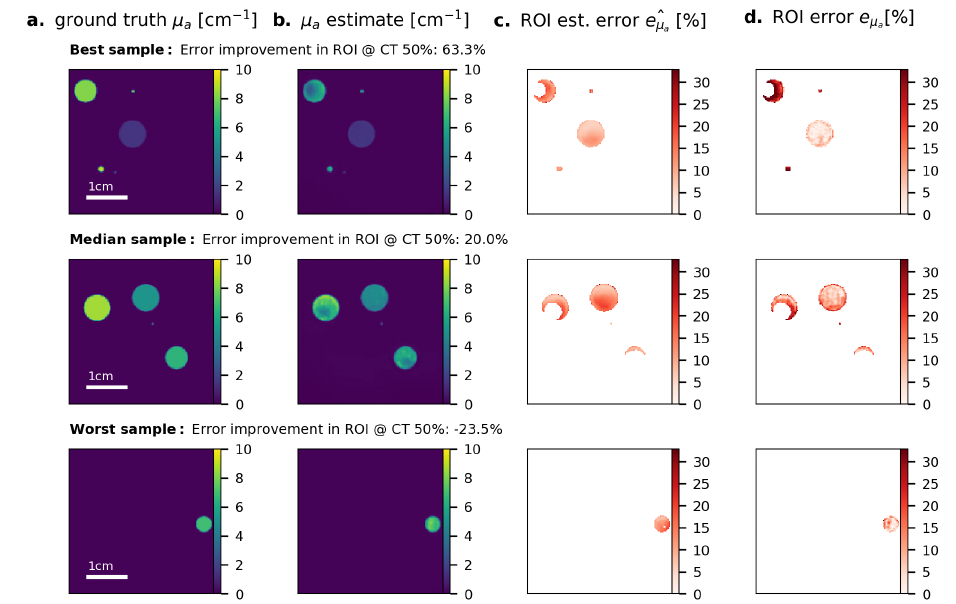
Figure A2. Sample images showing the best, the worst, and the median performance of our method when considering only the 50% most confident quantification estimations. All images show the ( a ) ground truth absorption coefficients ( b ) reconstructed absorption, ( c ) error estimate from external model, ( d ) the actual quantification error.